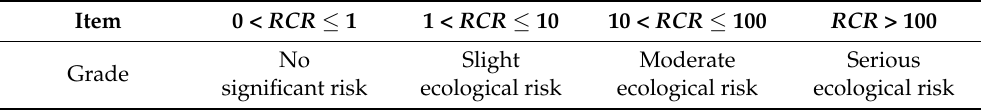
Figure 3. new fig 8. Table 3. Risk characterization ratio ( RCR ) ecological risk rating of